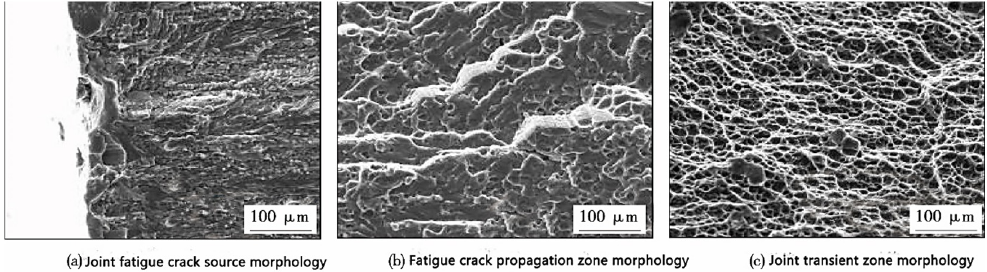
Figure 3. Fatigue fractography of 6005 aluminum alloys joint after stationary shoulder friction stir welding [32].